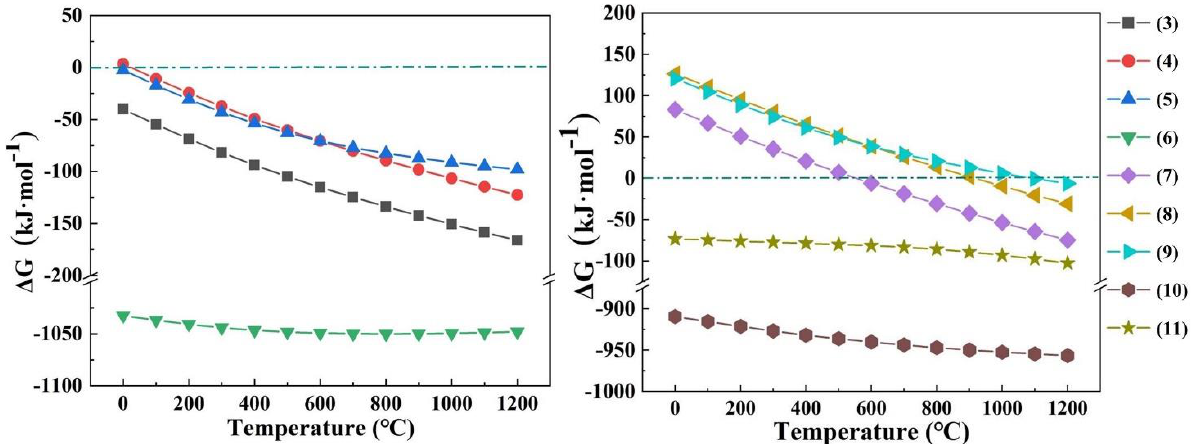
Figure 4. Relationship of the changes in Gibbs free energy with the temperature for the reactions during the roasting process.